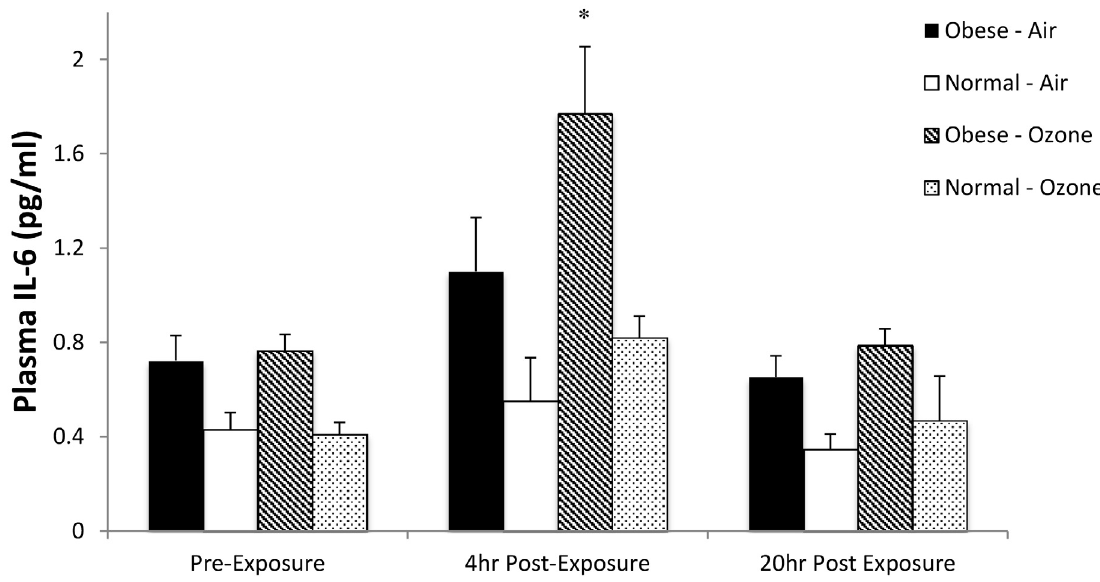
Fig 1. Mean (SE) plasma IL-6 concentrations for pre- vs. post-air and pre- vs. post-ozone exposure. Pre-exposure levels of IL-6 were less in normal weight than obese (Table 7). Both groups show significant increase in IL-6 4-hours post ozone exposure (P < 0.005). * P < 0.006 for Obese vs. Normal 4-hours post-ozone exposure.